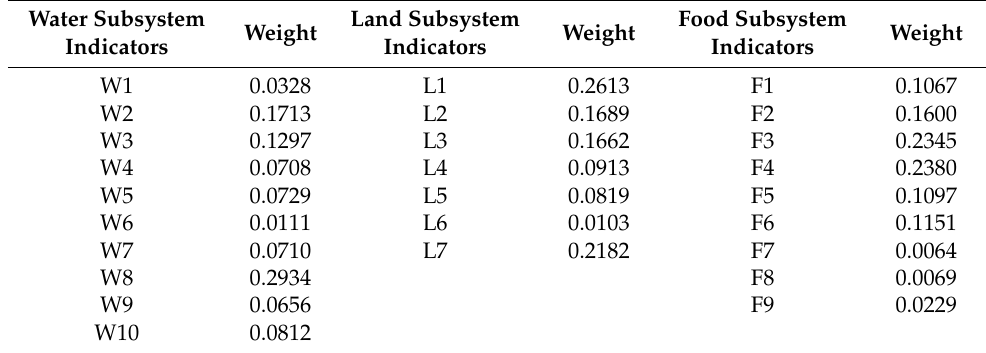
Table 3. The Weight of Each Evaluation Indicator in the WLF Nexus